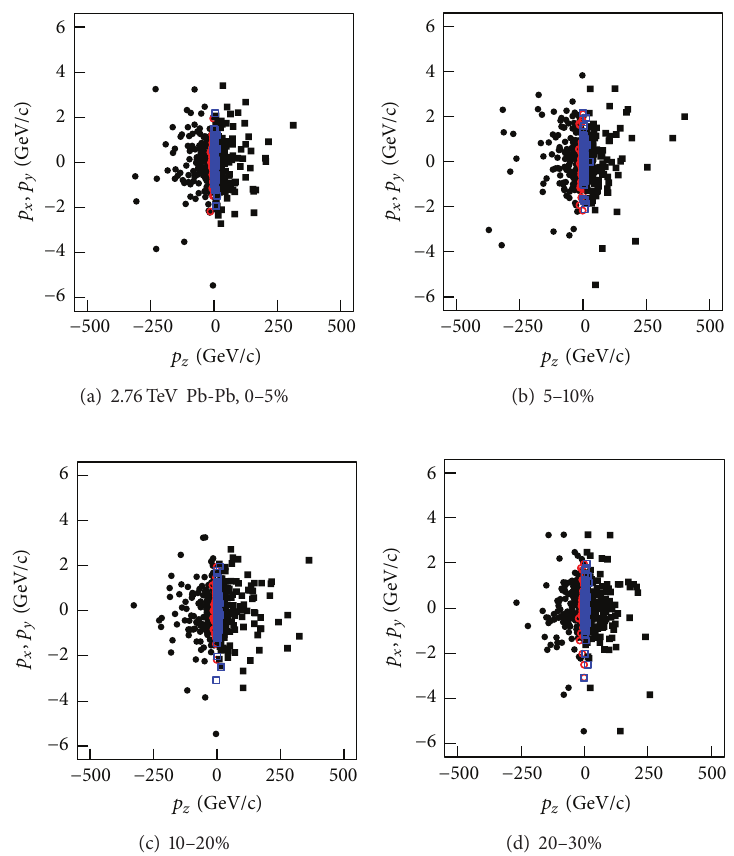
Figure 4: Extracted event shapes (dispersion plots) of 1000 charged particles at the stage of freeze-out in the momentum space 𝑝 𝑥 − 𝑝 𝑧 (or 𝑝 𝑦 − 𝑝 𝑧 ) in Pb-Pb collisions at √𝑠 𝑁𝑁 = 2.76 TeV in the centrality intervals (a) 0–5%, (b) 5–10%, (c) 10–20%, and (d) 20–30%. The closed circles, open circles, open squares, and closed squares represent orderly the contributions of leading target nucleons, target cylinder, projectile cylinder, and leading projectile nucleons from low to high in the longitudinal rapidity